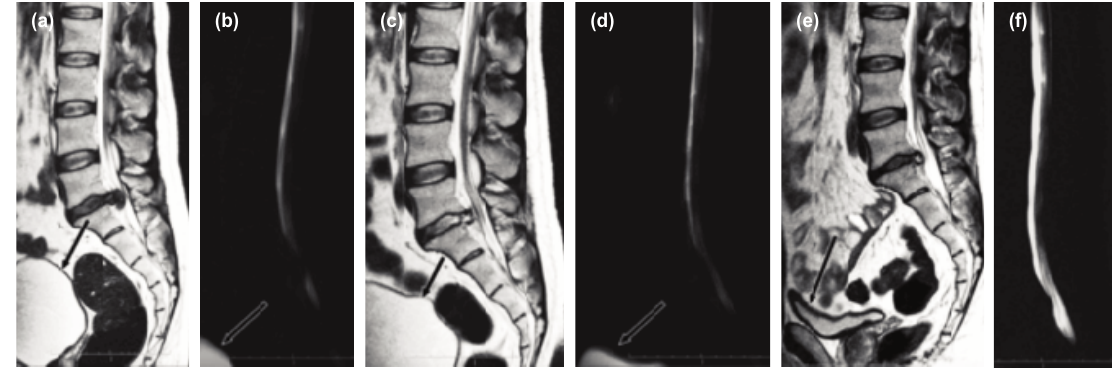
(a, b) MRI imaging in a patient with central big disc, complete myeloblock and CESR (Cauda Equina Syndrome Retention). Arrow Fig. 2: showing distended bladder in MRI and myelogram. (c, d) Immediate post-operatively, patient had slow urine stream and needed straining to empty. The MRI showing a complete decompression and a clear myelogram. Arrow showing distended bladder post- operatively in MRI and myelogram as well. (e,f) MRI and myelogram on follow-up ten days shows complete empty bladder (arrow) without any clinical bladder dysfunction.